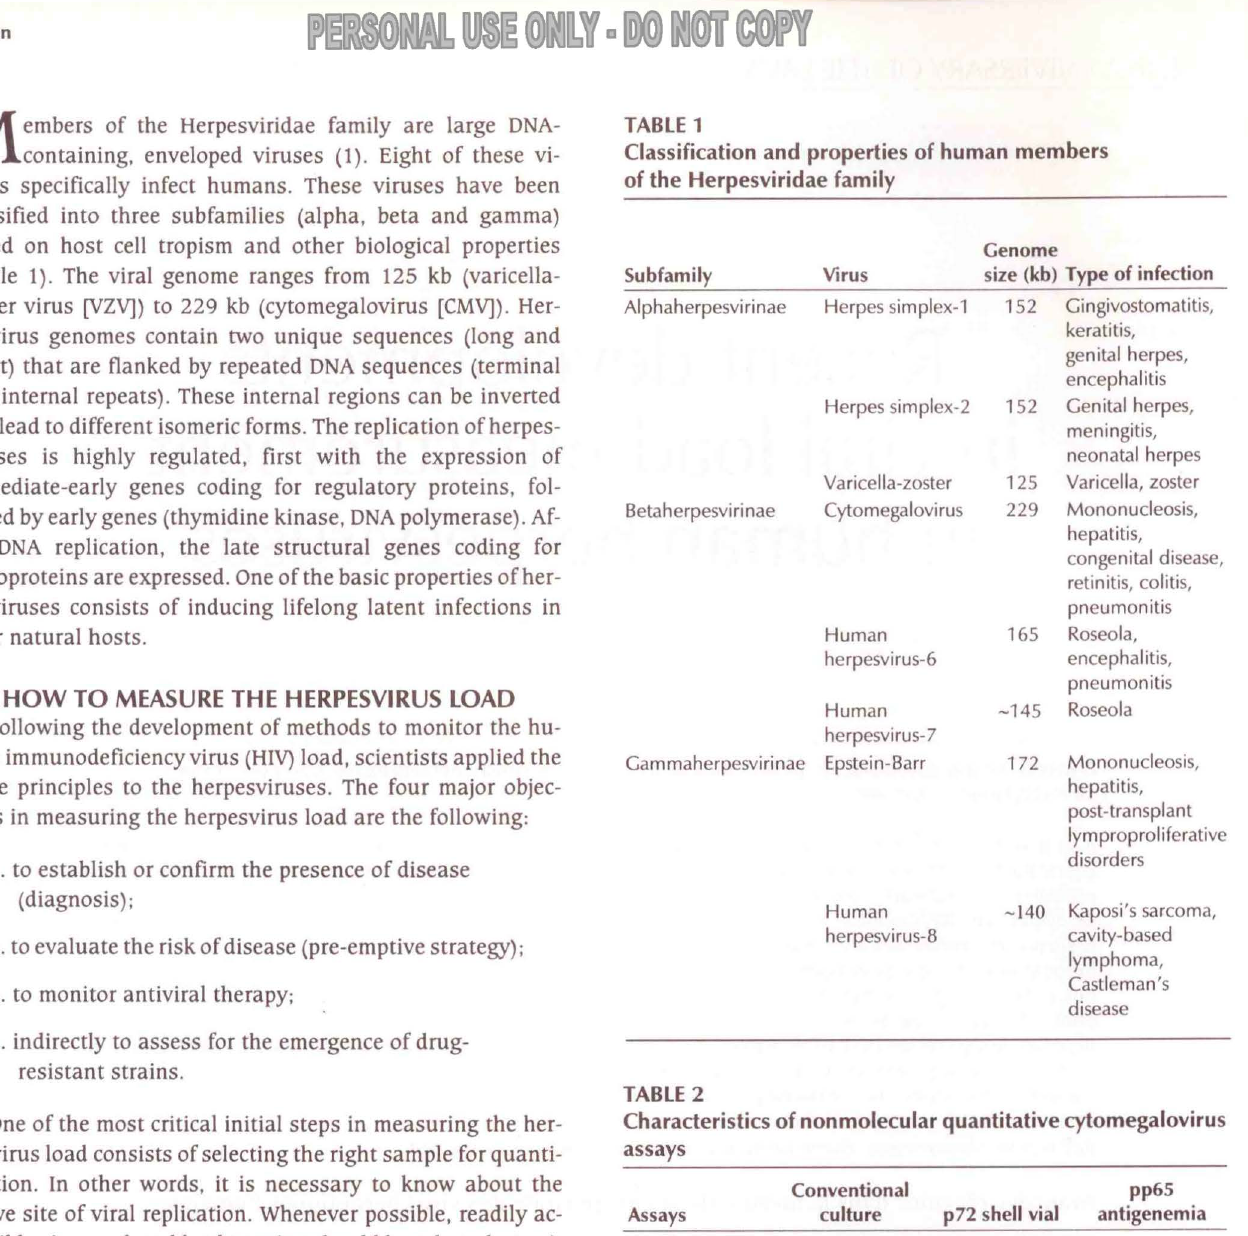
Classification and properties of human members